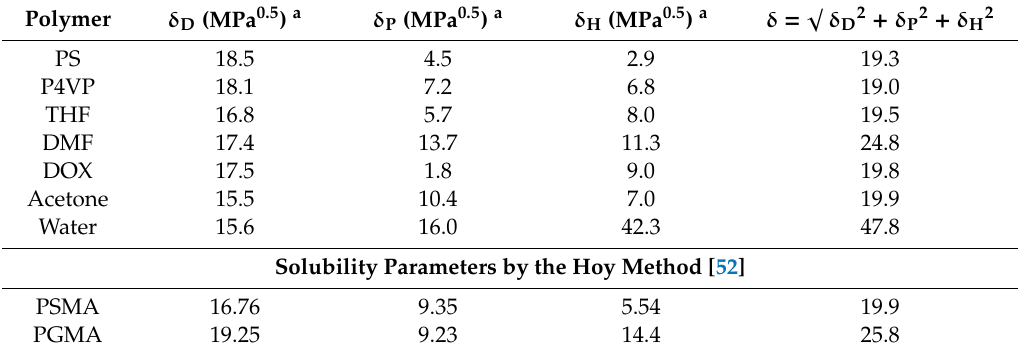
Table 2. Hansen solubility parameters ( δ ) of homopolymers, solvents, and non-solvents